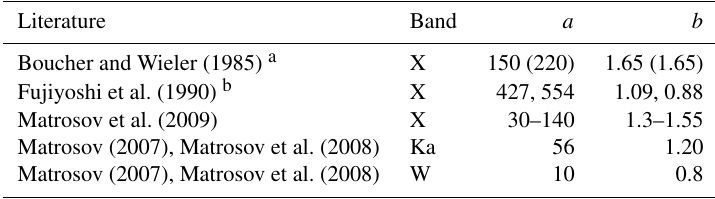
Table 3. The prefactors and exponents of the Z e – S relation in the literature for X, Ka and W band. Literature